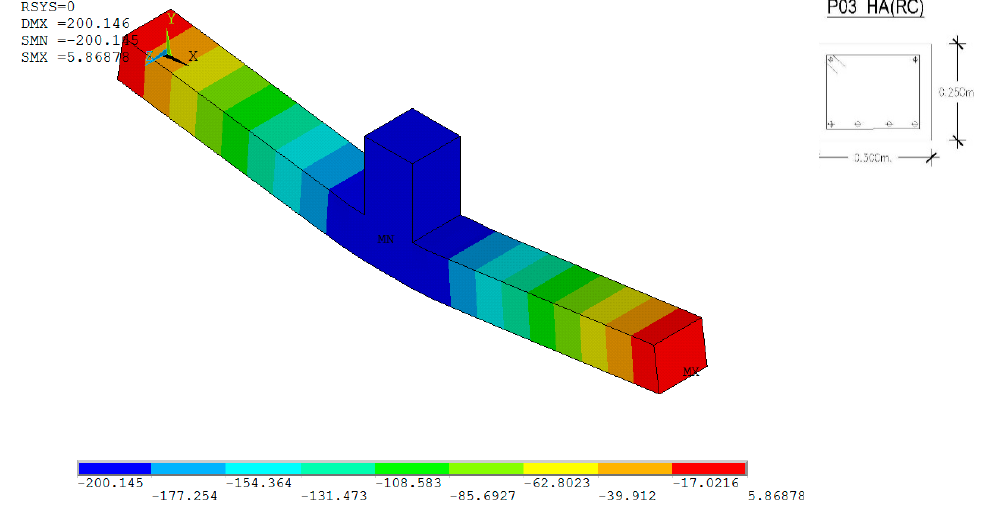
Figure 11. Deflection of the beam (in mm) for the 200 mm deflection.